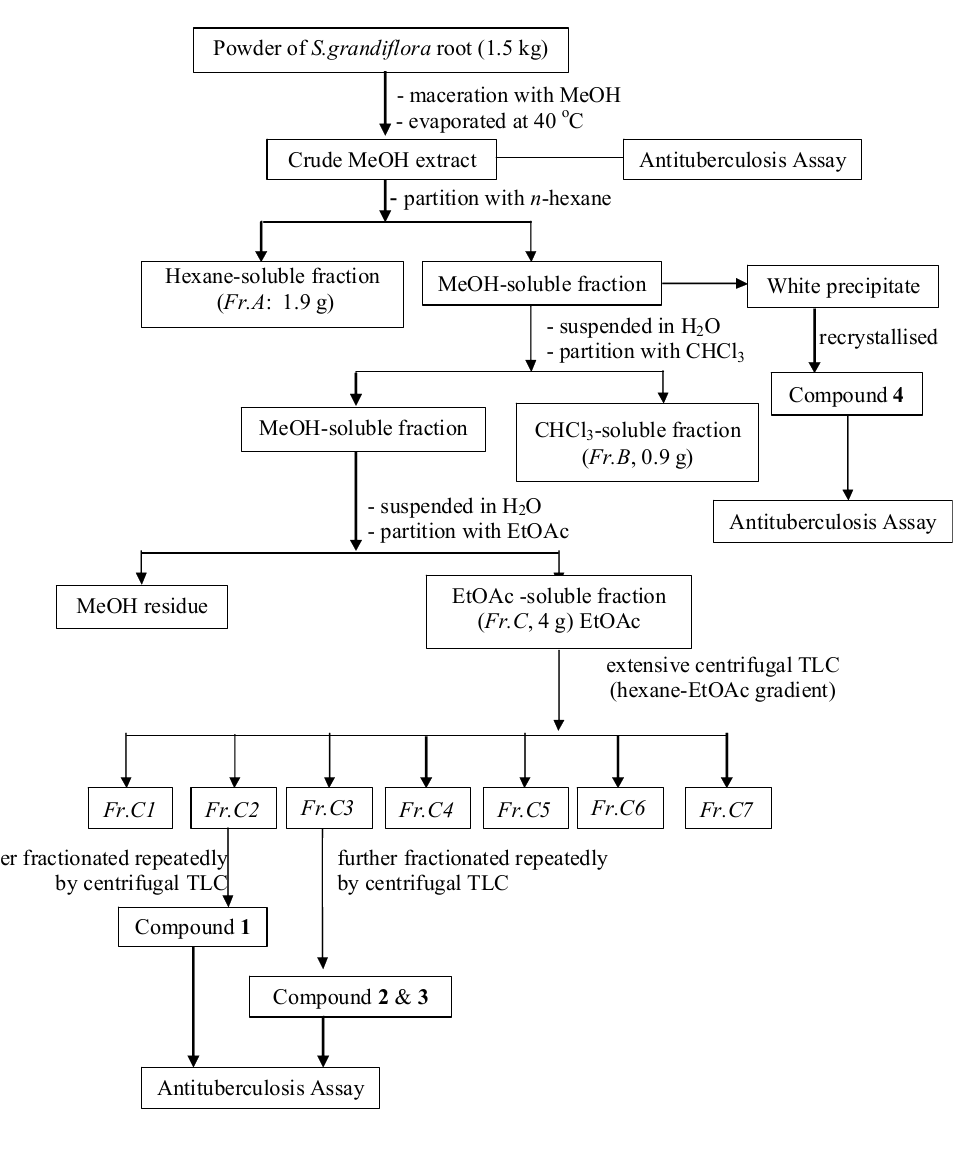
Figure 2. Flow chart of extraction and